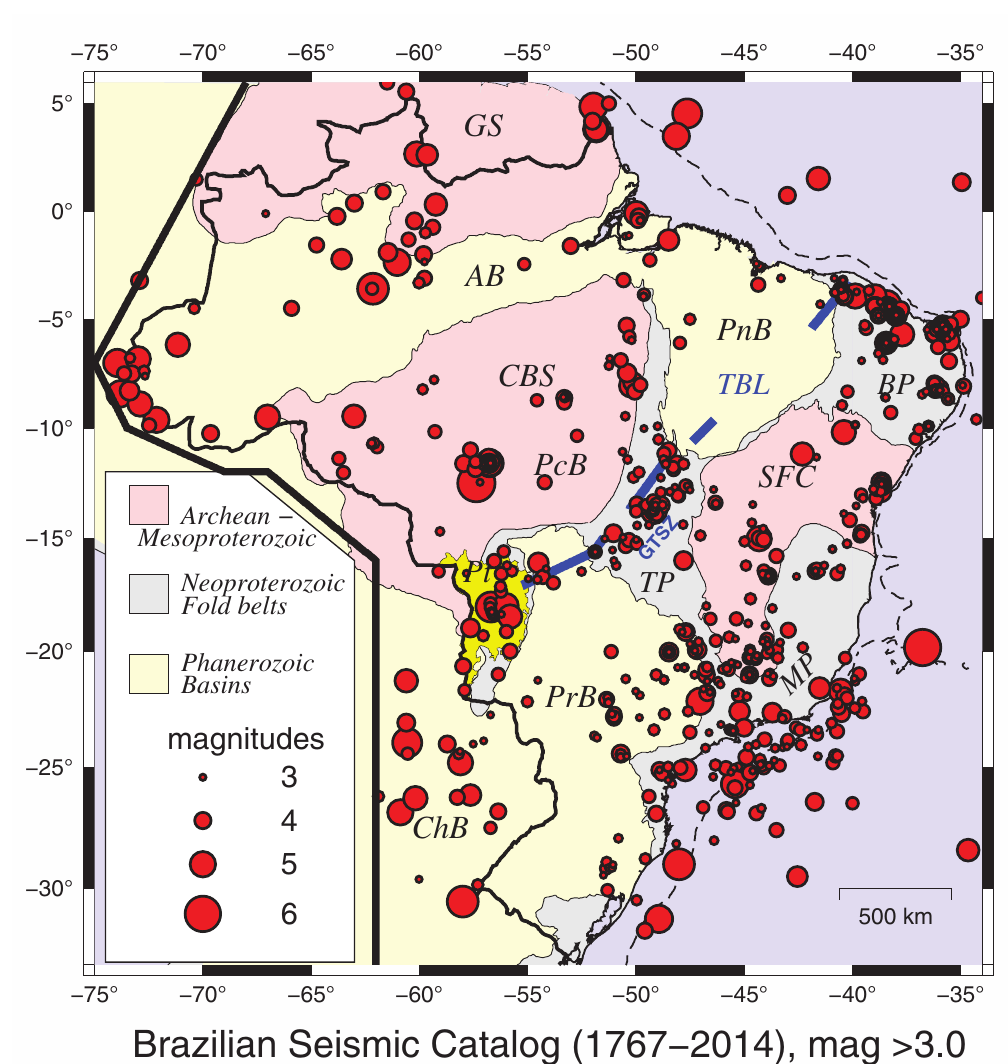
Figure 1 - Epicenters known in Brazil (Assumpção et al. 2014) and the main geological provinces of the country: GS = Guyana shield, CBS = Central Brazil shield, SFC = São Francisco craton; AB = Amazon basin, PnB = Parnaiba Basin, PcB = Parecis Basin, BP = Borborema Province, ChB = Chaco Basin, TP = Tocantins Province, PrB = Paraná Basin, MP = Mantiqueira Province. The total area of the Pantanal ( Pt ) is shown is highlighted. The bold line shows the strongest traits of Transbrasiliano Lineament ( TBL ) and Goiás-Tocantins Seismic Zone ( GTSZ ) is also